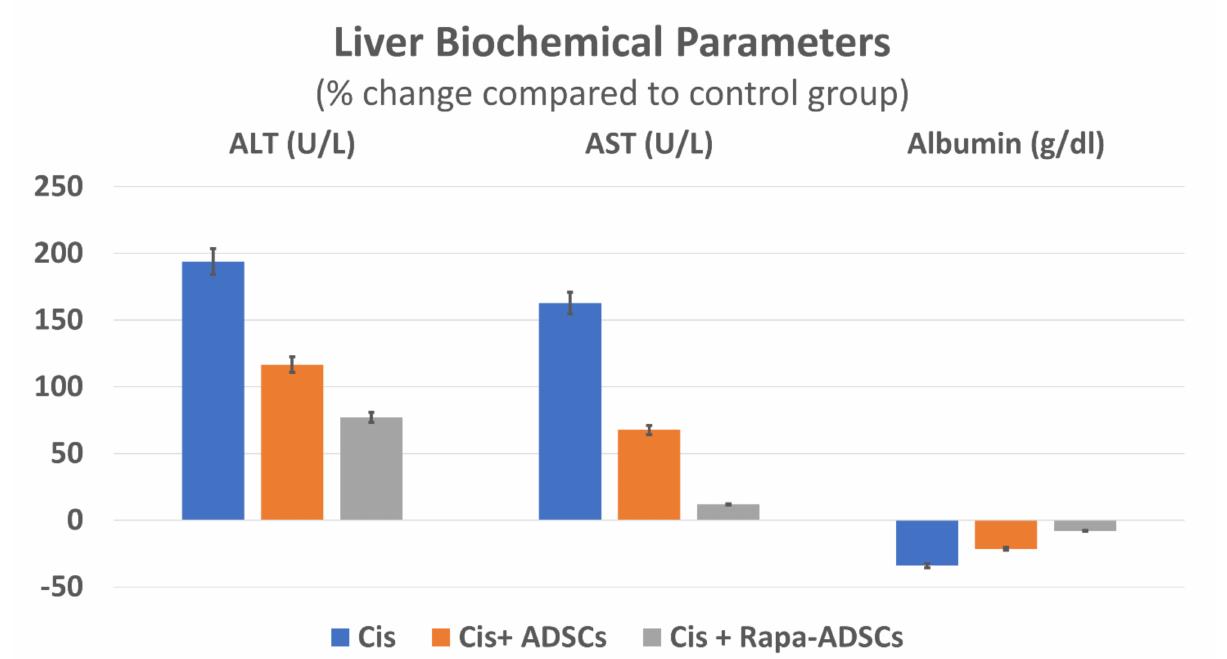
Figure 3. The effect of administering rapamycin-preconditioned ADSCs on liver biochemical parameters, AST, ALT and albumin in cisplatin (Cis)-induced liver damage. Cis, cisplatin (i.p. injection of 5 mg/kg in 0.9% saline) group; Cis + ADSCs, cisplatin group receiving ADSCs (one million cells, intravenous in tail vein); Cis + Rapa-ADSCs, cisplatin group receiving same number of ADSCs preconditioned with rapamycin (50 nM/L, 2 h prior to